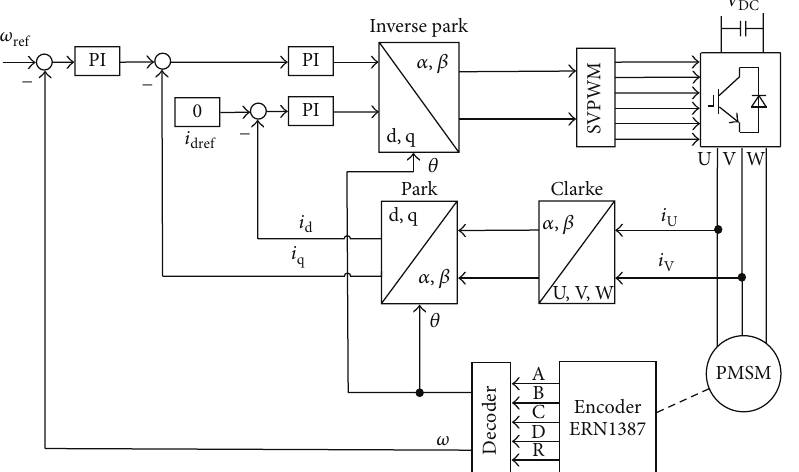
Figure 5: The diagram of PMSM drive and control system.